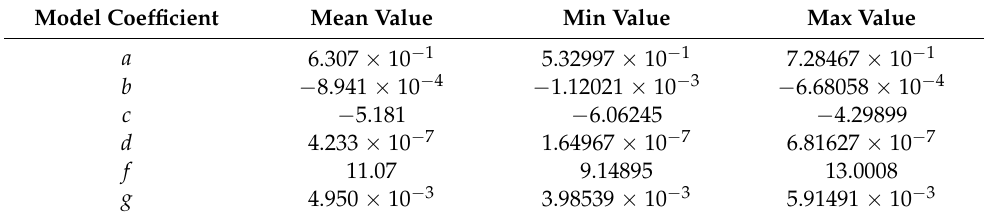
Table 7. Model coefficients obtained for the mathematical model representing the functional relation- ship between the absorbance at 1060 cm − 1 with the dimensionless parameter C/N and C/K . Model Coefficient